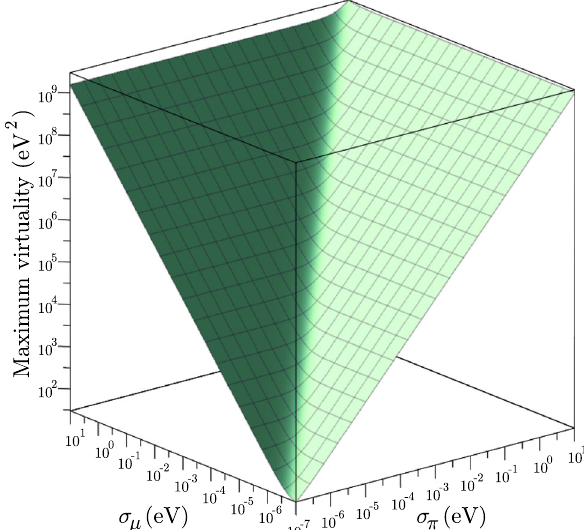
Fig. 3 Maximum permissible neutrino virtuality vs. σ π and σ μ esti- mated in the π - μ model. Calculation is made assuming energy– momentum conservation and neglecting the neutrino mass